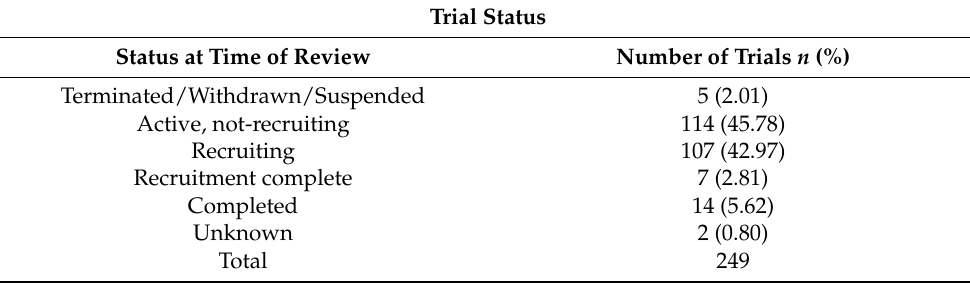
Table 2. Eligible COVID-19 vaccine trial status at time of review.